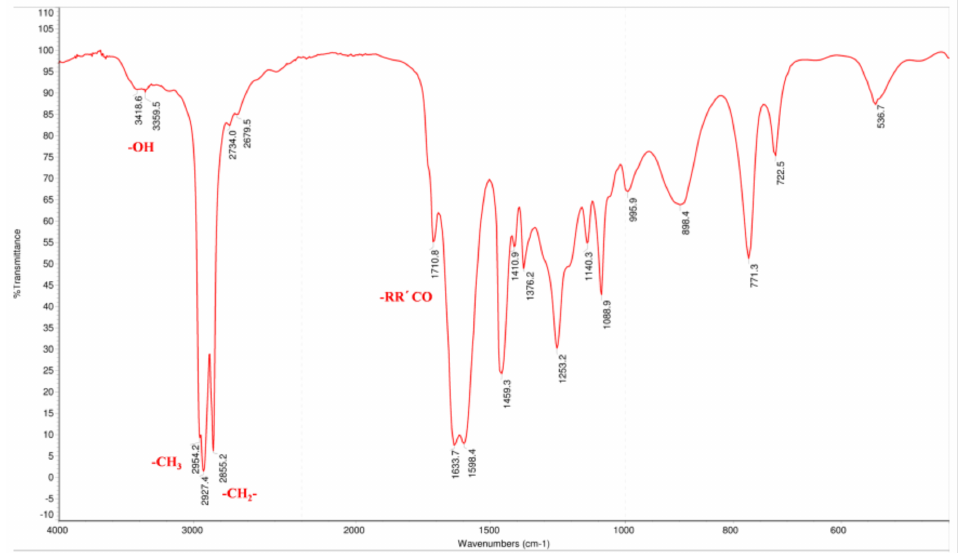
Figure 2. The IR spectrum of Hou. The 1 H NMR spectrum (Figure 3) indicated an aldehyde hydrogen at δ H 7.88 (1H, d, J = 4.0 Hz), a conjugated enol hydrogen at δ H 5.49 (1H, d, J = 4.0 Hz), a methyl signal at δ H 0.83 (3H, t, J = 7.0 Hz), and eight methylene signals at δ H 2.31–1.21. The 13 C NMR